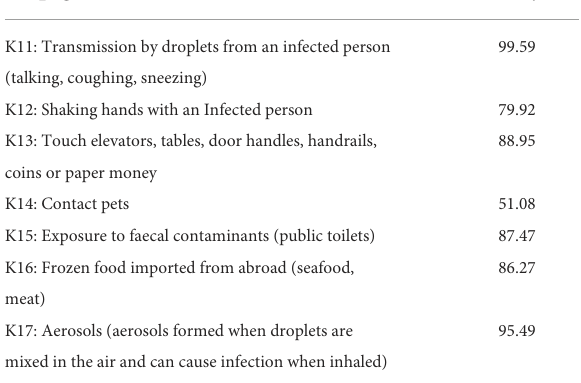
TABLE 2 Transmission mode of COVID-19.